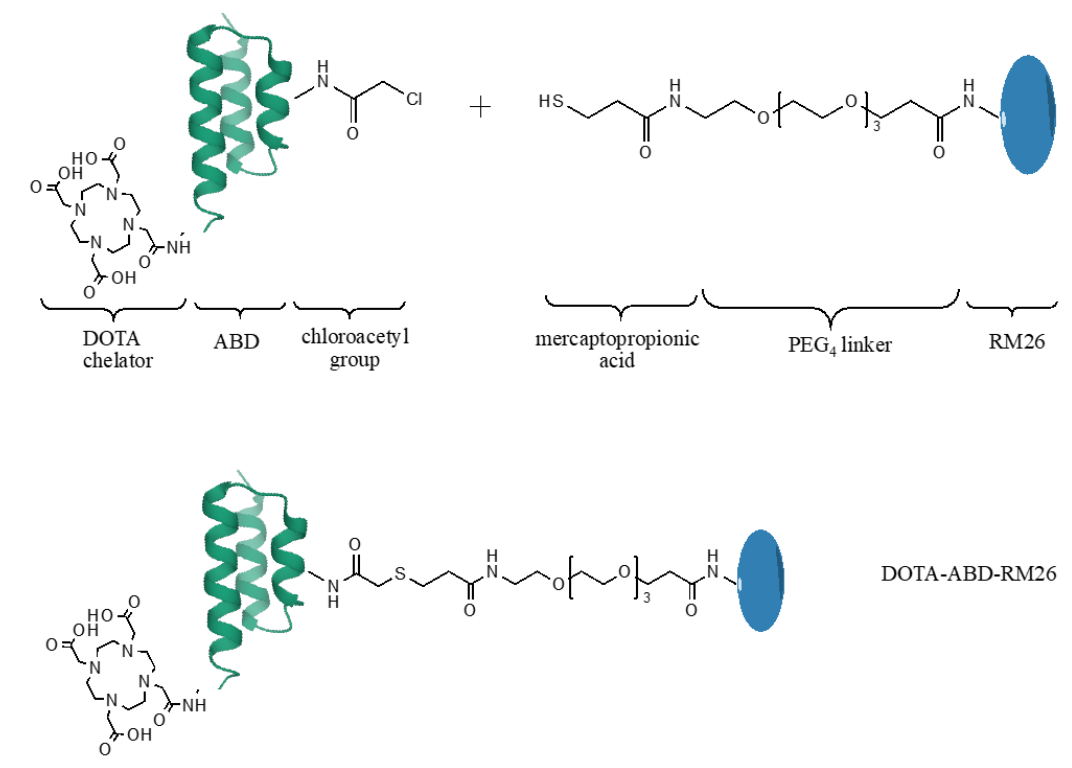
Figure 1. Schematic protocol for production of the DOTA-ABD-RM26 conjugate.